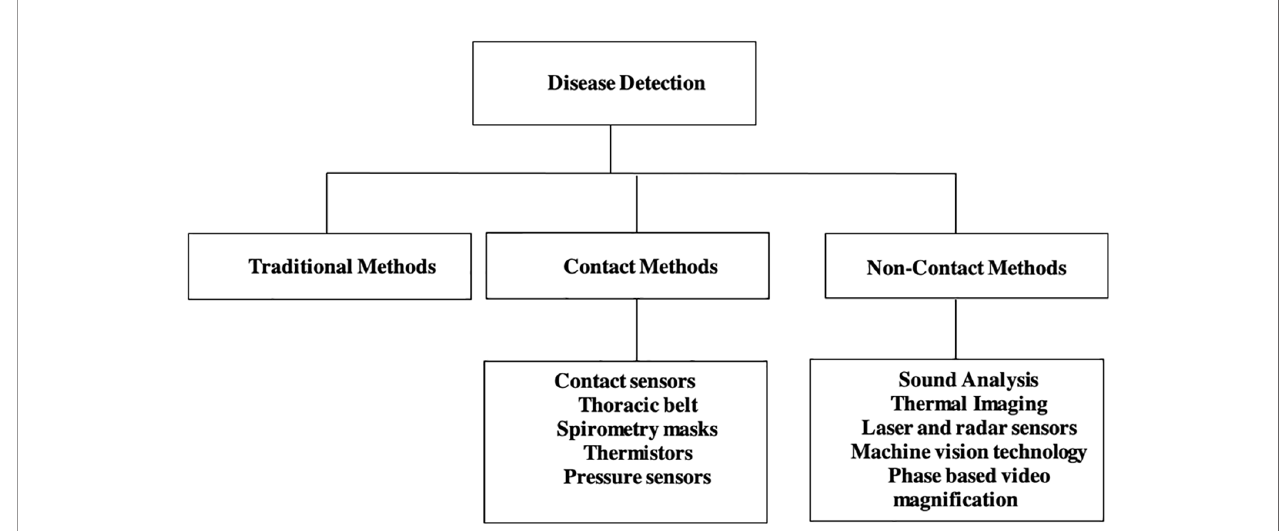
FIGURE 1 | Taxonomic organization of respiratory disease